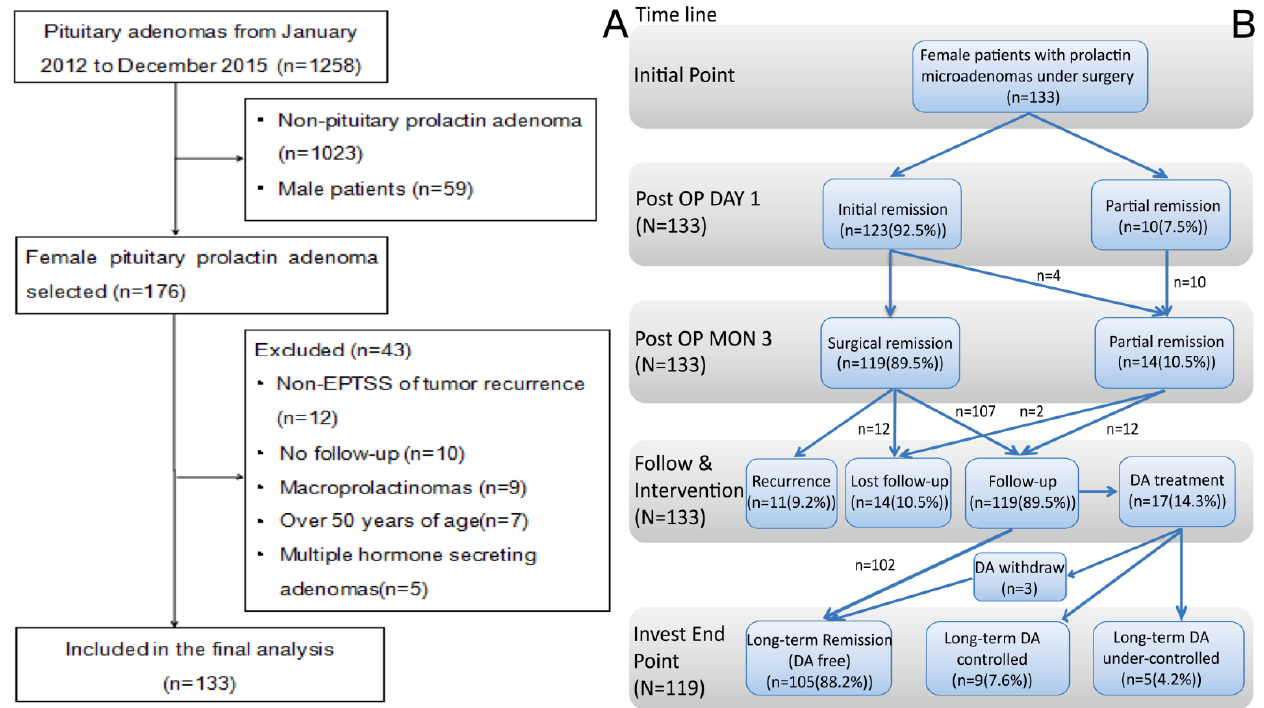
Figure 1. ( A ) The patient selection process is depicted in a flow chart. Surgery was conducted on 176 female pituitary prolactin adenoma patients out of 1258 patients with pituitary adenoma, with 133 patients included in the final study due to the presence of complete data. ( B ) Flowchart of treatment and prognosis of 133 female patients with microprolactinoma. All 133 female patients with microprolactinoma underwent transsphenoidal microsurgery to resect the tumor. Out of 123 (92.5%) patients who had initial remission, 10 (7.5%) patients had partial remission on the first day postoperatively. Three months after surgery, 119 (89.5%) patients achieved surgical remission, whereas 14 (10.5%) patients were in partial remission. A total of 14 (10.5%) patients were lost to follow-up, while 11 (9.2%) developed tumor recurrence during subsequent follow-up. Addition- ally, 102 (85.7%) of the 119 (89.5%) patients who were followed up on achieved long-term remission (DA free), 17 (14.3%) were treated with dopamine agonists (DA), 3 (17.6%) achieved remission after discontinuing DA therapy, 9 (53.0%) required long-term DA control and 5 (29.4%) were un- der-controlled with long-term DA therapy. EPTSS—extra-pseudocapsular transsphenoidal surgery; DA—dopamine agonists